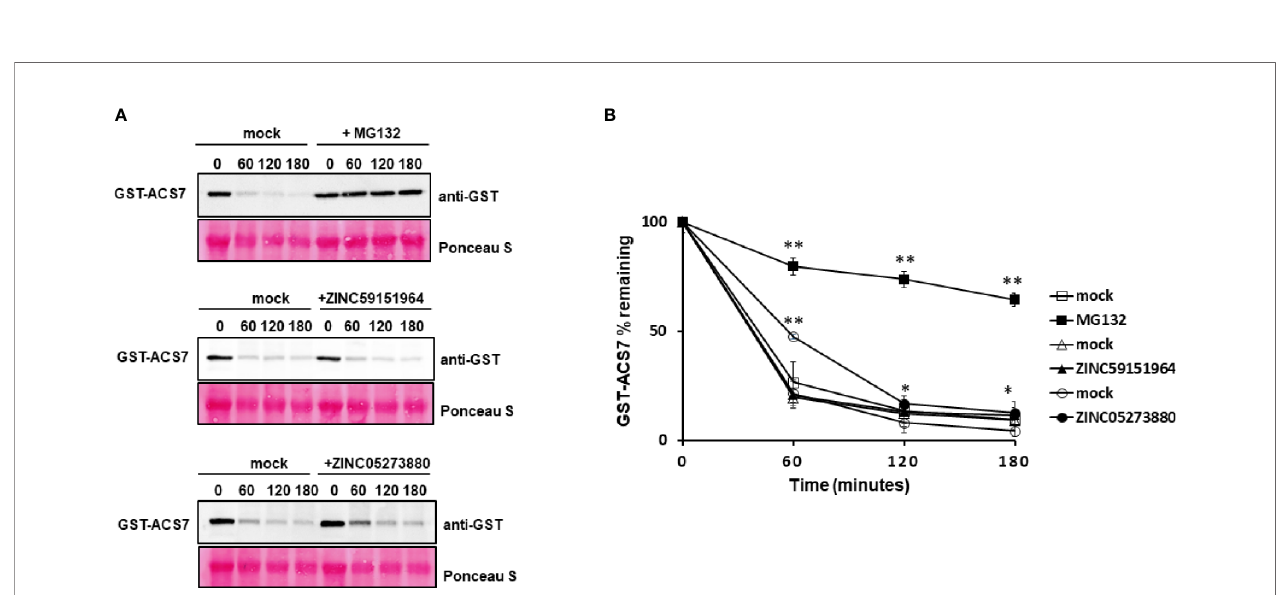
FIGURE 9 | Cell-free degradation of recombinant GST-ACS7 protein. (A) Recombinant ACS7 protein was incubated with WT Col-0 protein extracts treated with or without MG132, ZINC95151964, and ZINC05273880 for the indicated times. The GST-ACS7 level was visualised by immunoblotting using anti-GST antibodies. Equal protein loading was shown by Ponceau S staining; (B) Half-life plot for cell-free degradation of ACS7 after MG132, ZINC95151964, and ZINC05273880 treatment. The GST-ACS7 bands were quanti fi ed using ImageJ software. Error bars indicate the SD (n = 4 – 6 replicates per time point) and the asterisks indicate a signi fi cant difference between mock and inhibitor treatment (based on Student ’ s t-test **p < 0.0001; *p <